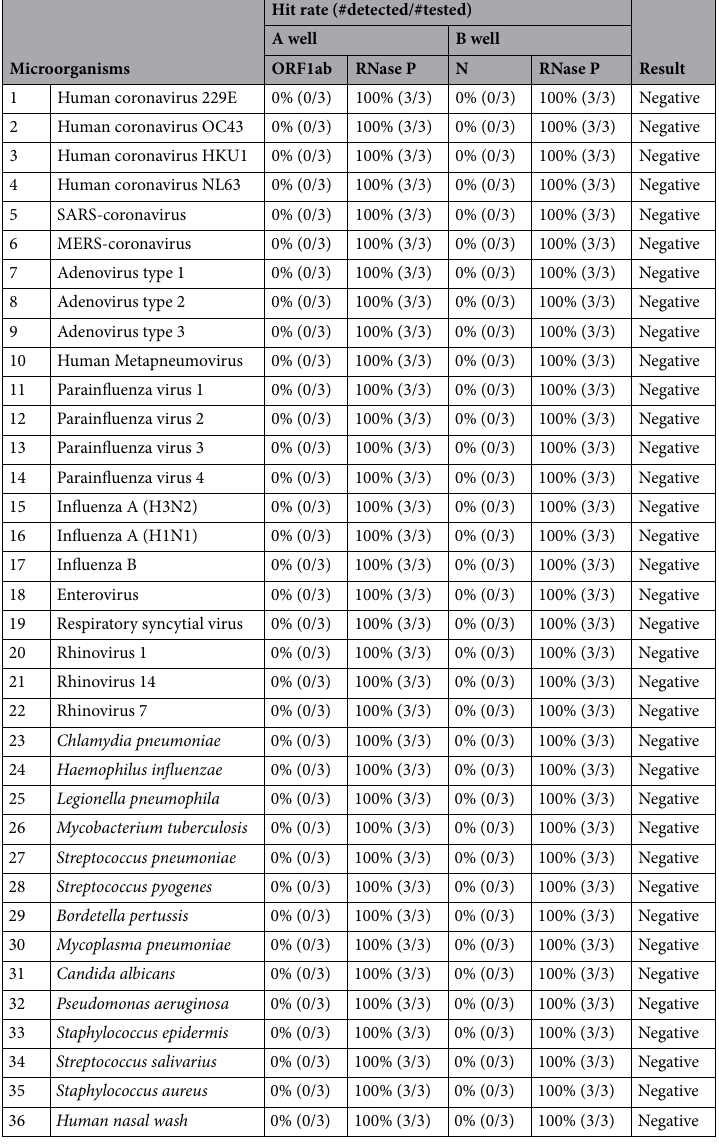
Table 2. Summary of cross reactivity study. RNA extracts from all tested microorganisms as well as direct human nasal wash were confirmed to not cross-react with PNA RT-LAMP